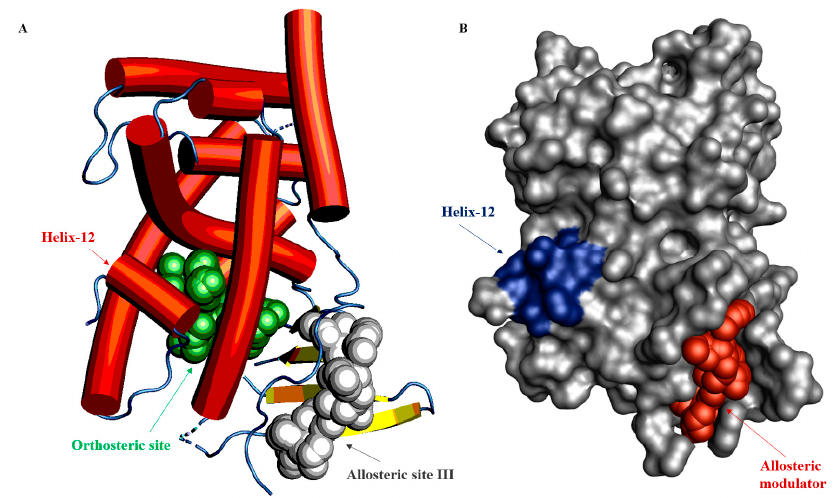
Figure 8. Machine-learning technologies to predict PXR allosteric sites. ( A ) Cartoon structures of the PXR illustrate the orthosteric and allosteric sites. Crystal structure (PDB–5 × 0 R) was used to predict a novel allosteric site using the AlloFinder online server. The green spheres depict the orthosteric ligand binding pocket, and the identified allosteric binding site III is indicated using grey spheres as a ligand. Red arrows point to the helix 12 position. Helix 3 and a beta-sheet (yellow) form the allosteric ligand binding site III. ( B ) Surface structure representation of the allosteric binding site III. The surface of the PXR receptor is gray. Helix 12 is indicated in blue and a hypothetical allosteric modulator in red. Both structures are in the same orientation.